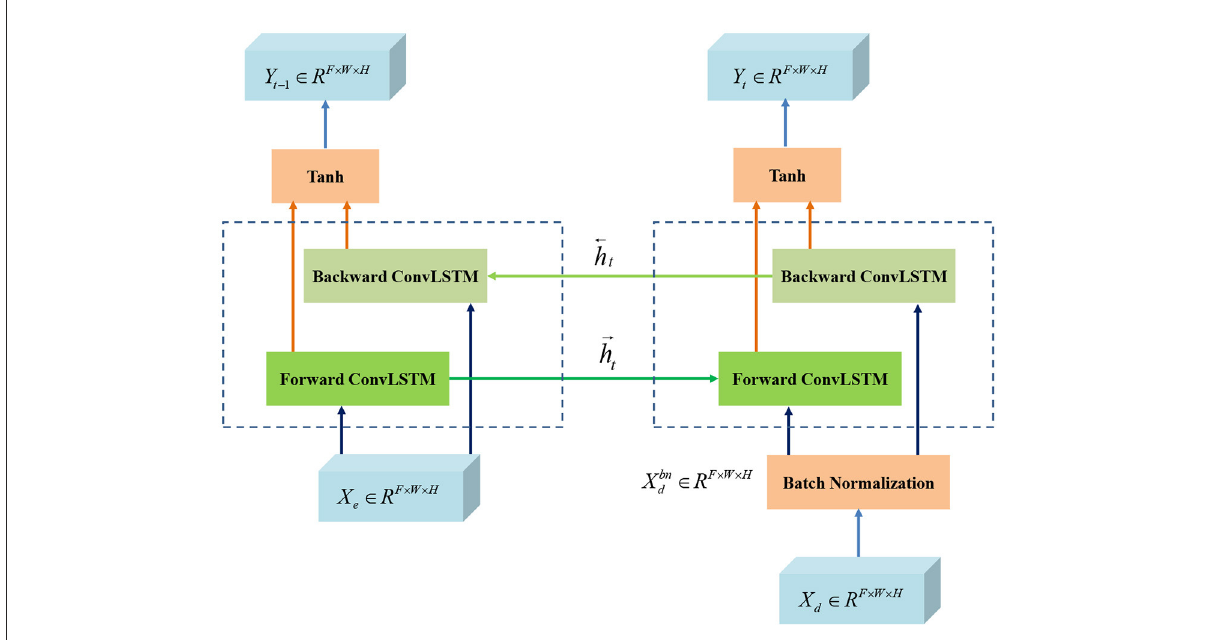
FIGURE3 The flowchart Bi-directional